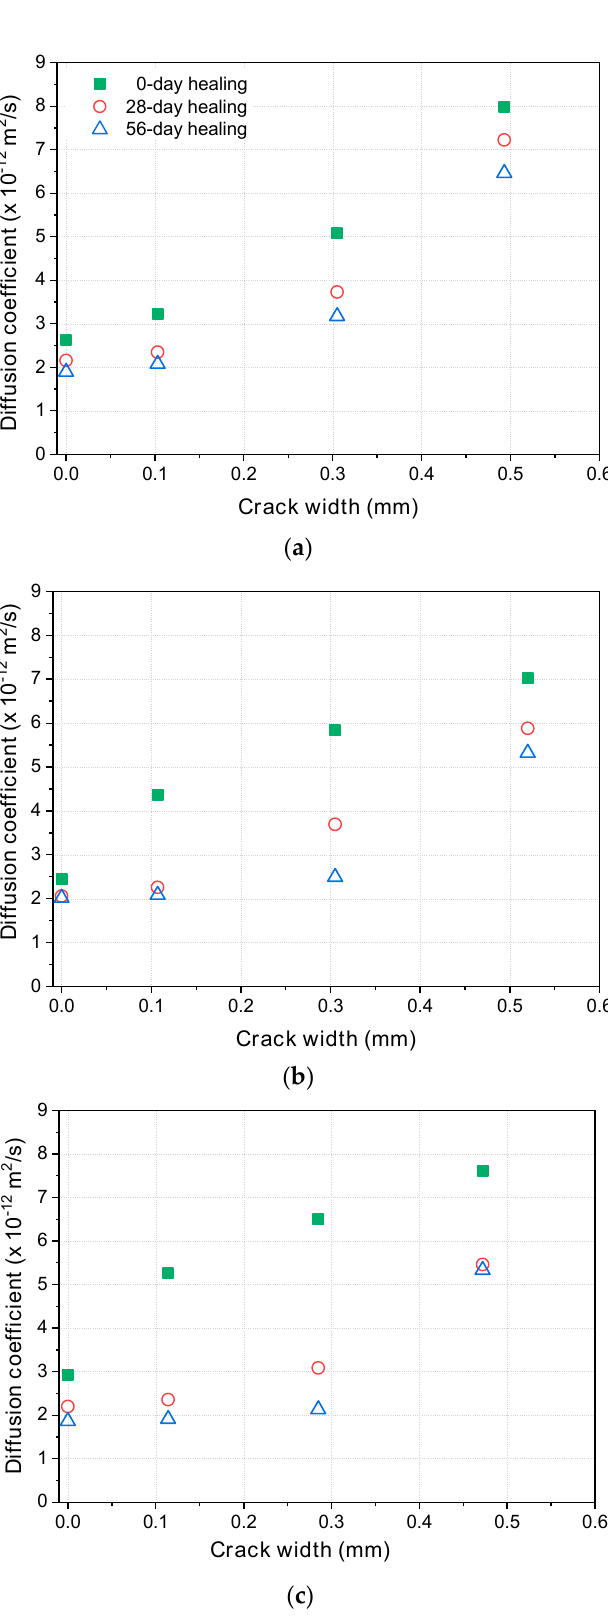
Figure 11. Indices for the self-healing capacity of different mixtures: ( a ) OPC; ( b ) SH-A; ( c ) SH-B.